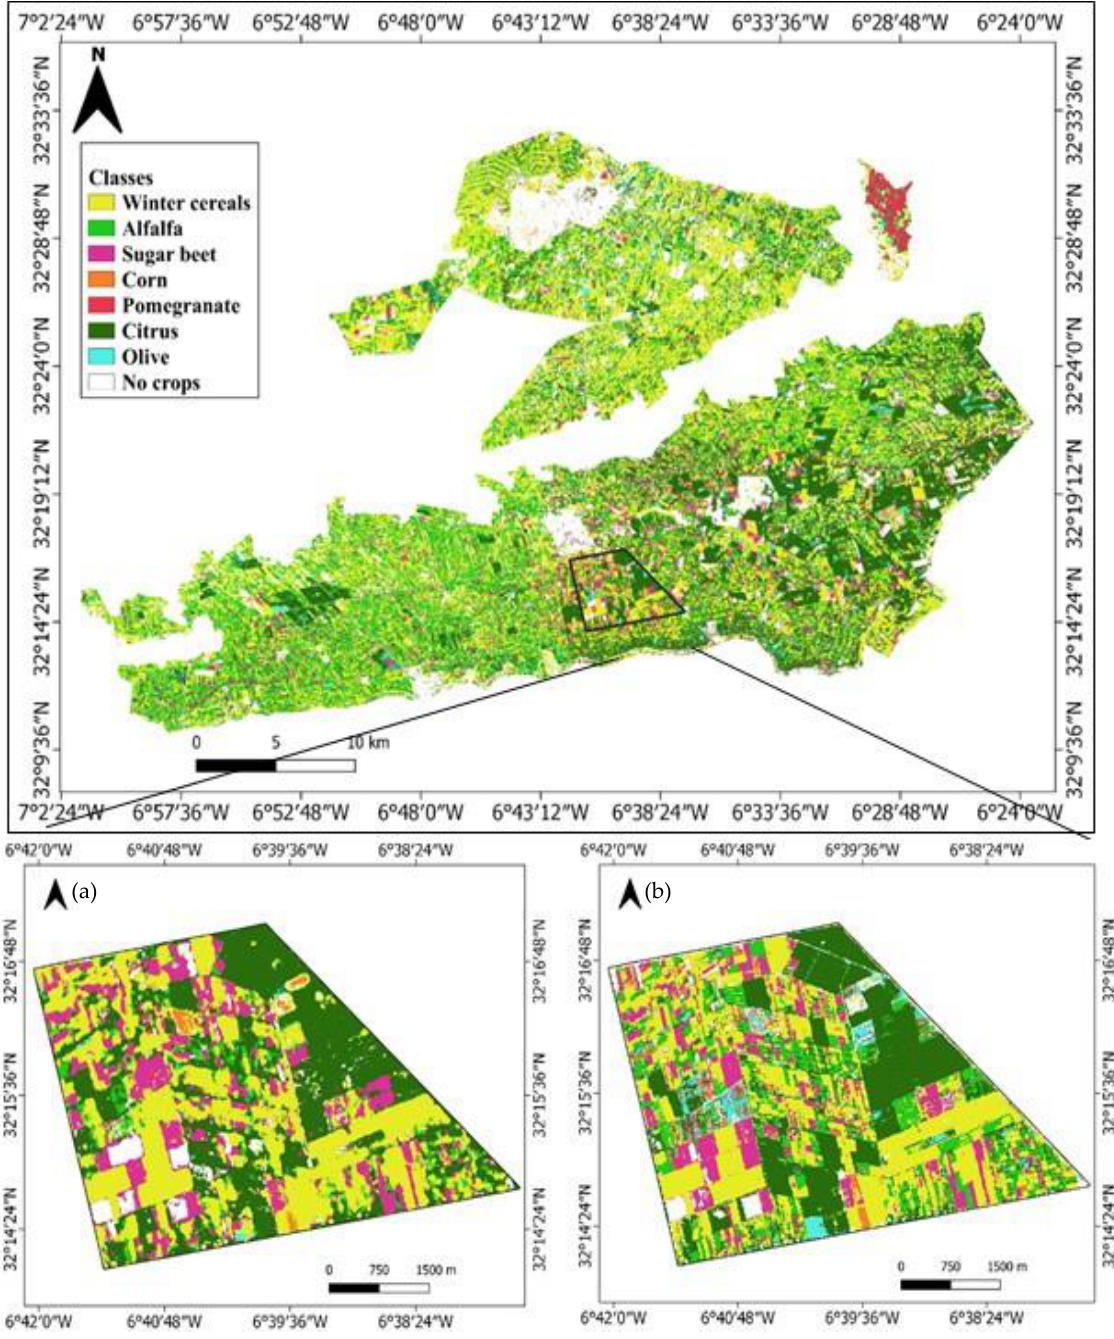
Figure 14. A detailed zoom for the crop classification results when using Sentinel-1 ( a ) and Senti- nel-2 ( b ).